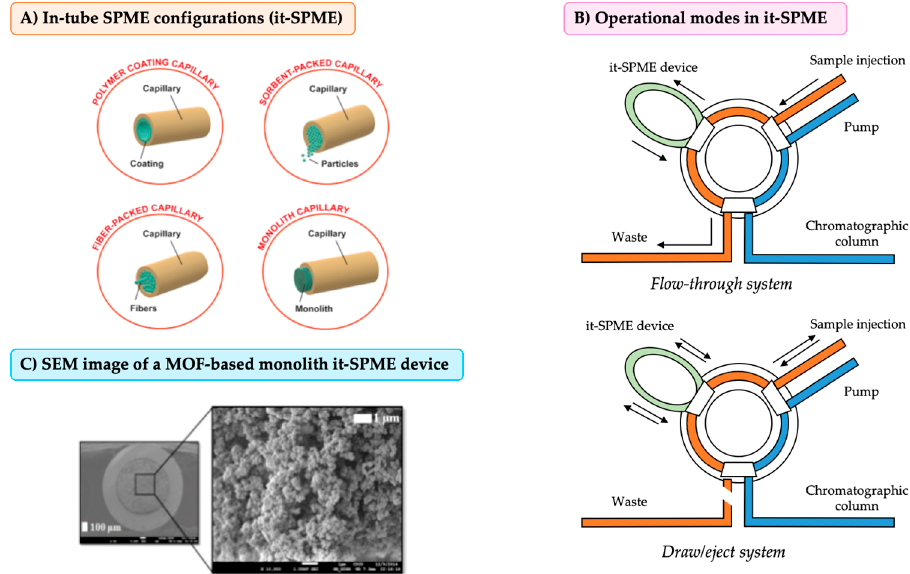
Figure 6. ( A ) Scheme of generic it-SPME devices reported in the literature. Adapted from [44], with permission from Elsevier, 2019. ( B ) Scheme of the two general operation modes of it-SPME devices. ( C ) Image of a MOF-based monolithic it-SPME device. Adapted from [123], with permission from Elsevier, 2016.